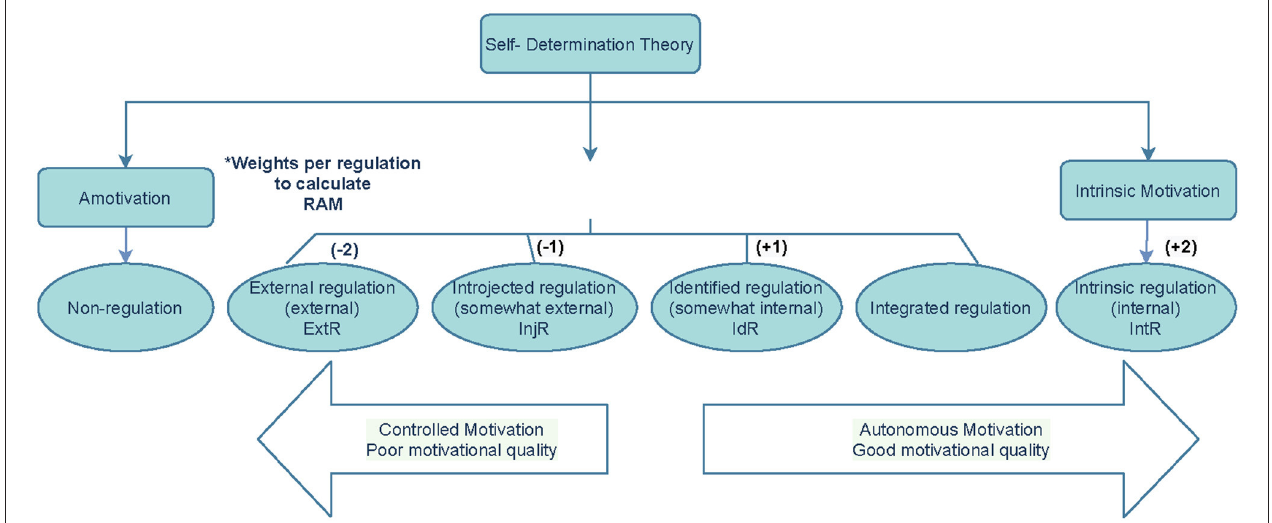
FIGURE 1 | Illustration of the Self-determination Theory adapted from Deci and Ryan (12). *Relative Autonomous Motivation (RAM) = ( − 2ExtR) + ( − 1lnjR) + (1xldR) +